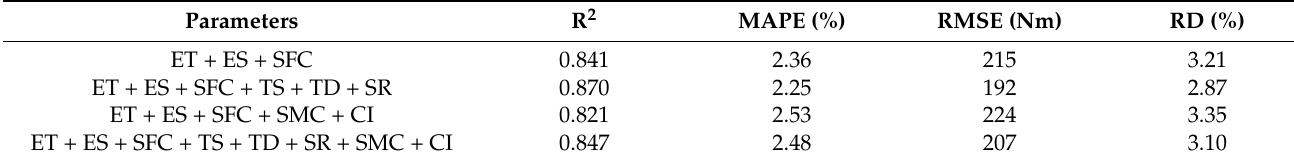
Table 6. Performance on the validation set for ANN-based axle torque estimation models.